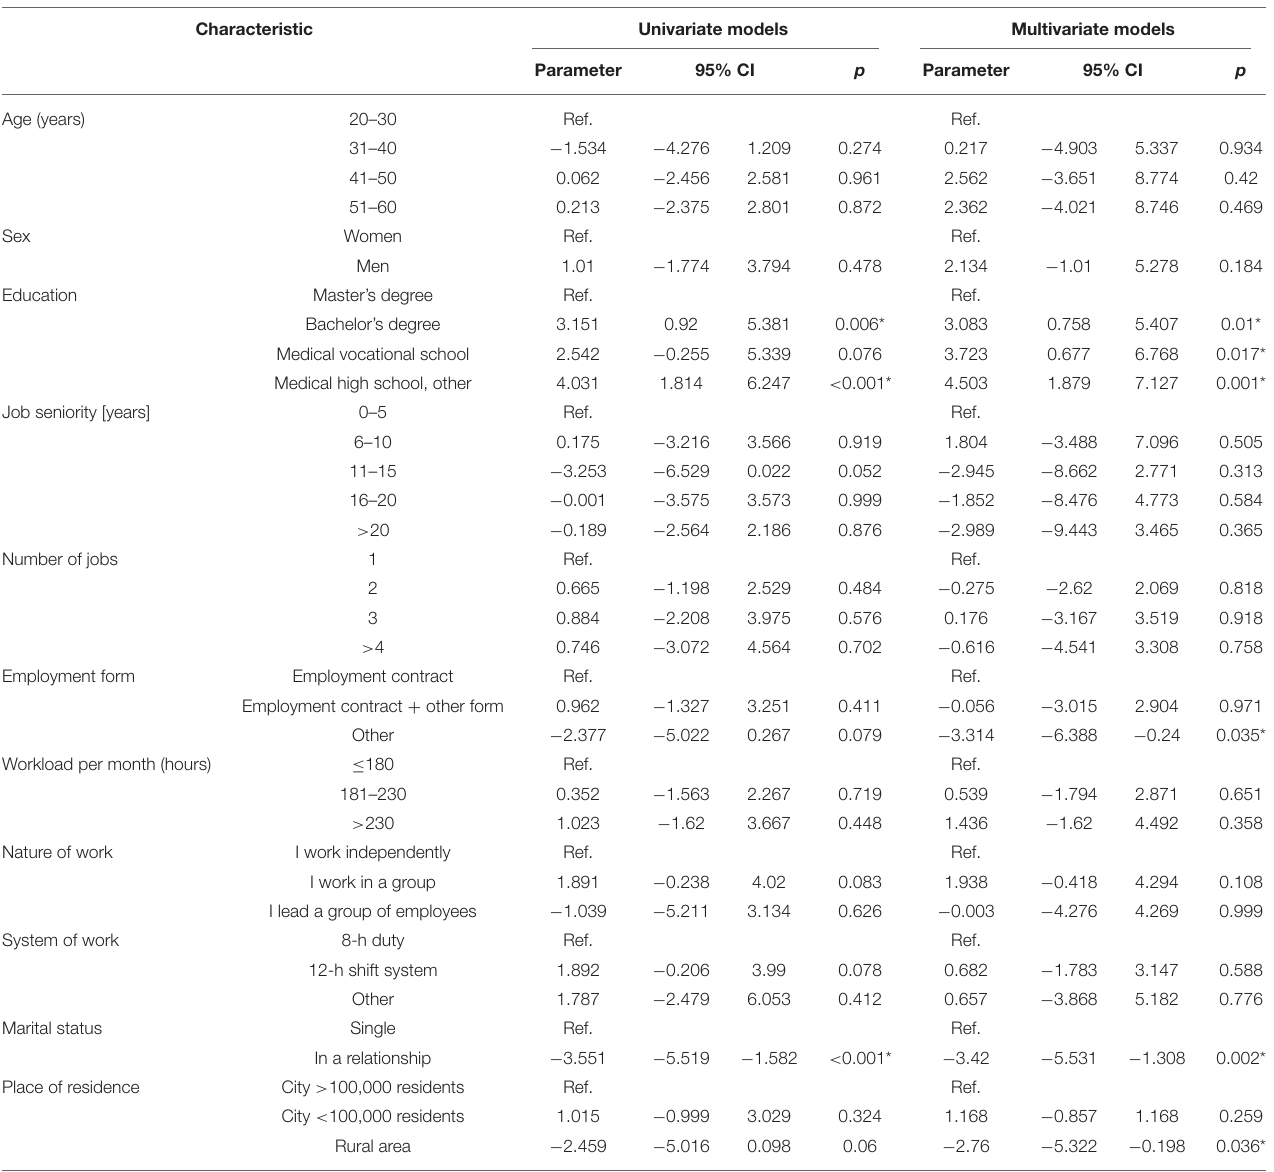
TABLE 4 | Univariate and multivariate analyses for